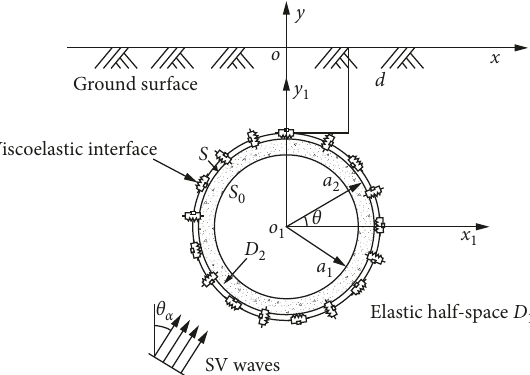
Figure 1: Seismic response model of tunnel lining with the viscous- slip